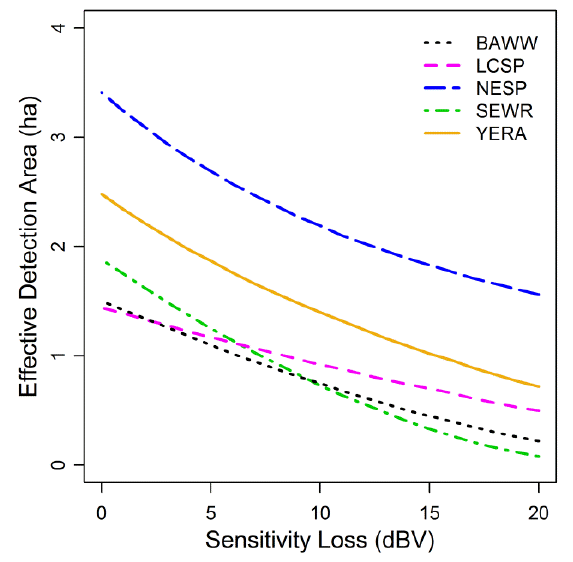
Fig. 5 . Effective detection area (ha) of Black-and-white Warbler (BAWW), Le Conte’s Sparrow (LCSP), Nelson’s Sparrow (NESP), Sedge Wren (SEWR), and Yellow Rail (YERA) calls during Beaufort 2 noise conditions (42 dBA) for increasing degrees of microphone sensitivity loss (dBV).